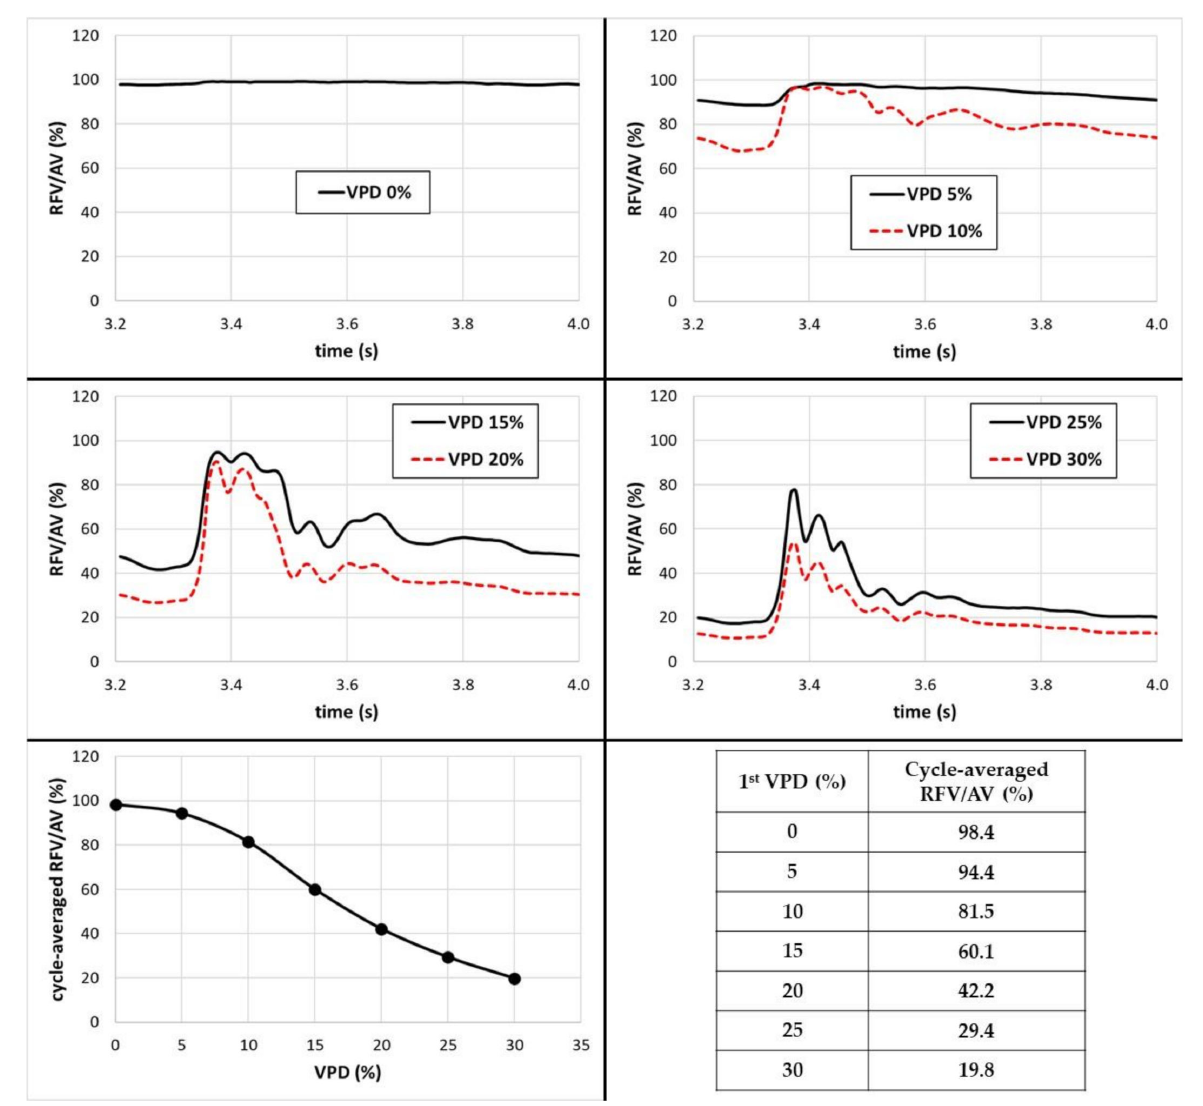
Figure 15. Time-dependent RFV/AV ratio together with cycle-averaged